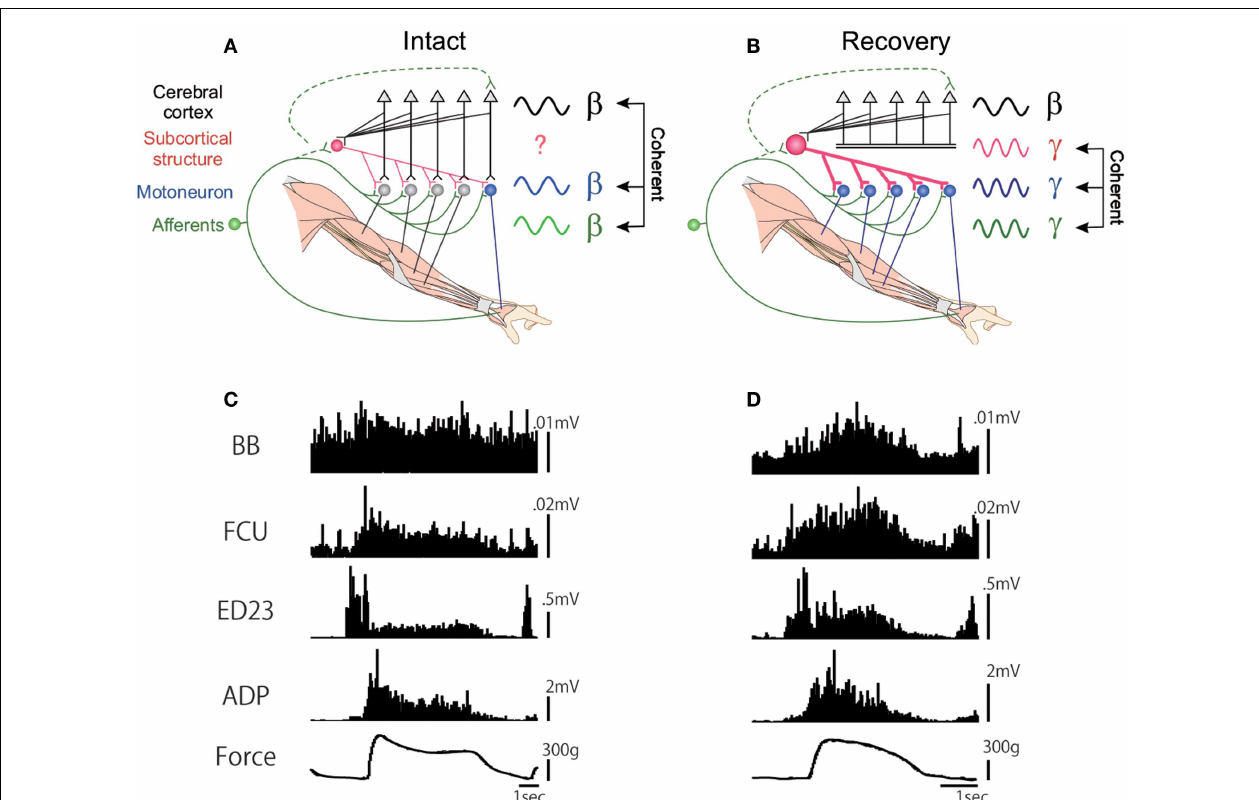
coherence but appearance of musculo-muscular coherence (at γ -band) after recovery from the C5 l-CST lesion. (D) EMG recordings during the force-tracking precision grip task 91days after lesion. FCU, flexor carpi ulnaris; ED2,3, extensor digitorum 2,3; ADP, adductor pollicis [modified from Ref.